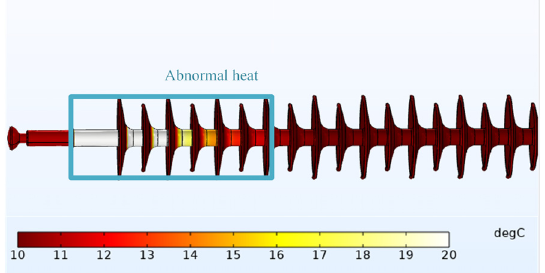
Figure 9. Simulation diagram of #1’s temperature rise.